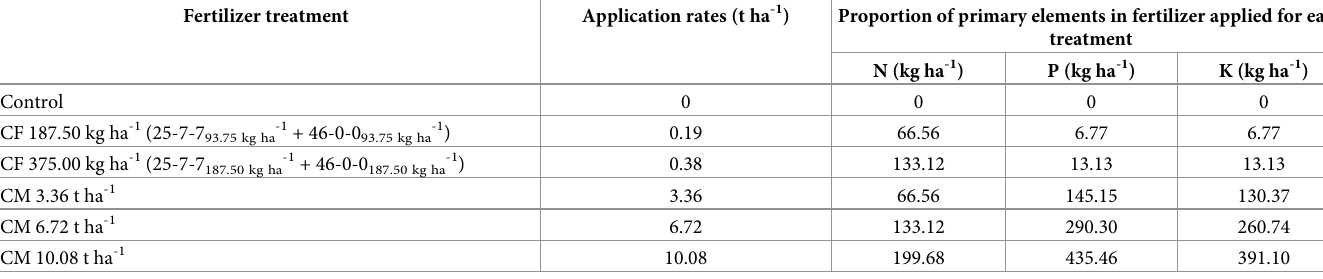
Table 2. Background plant nutrient contents when various fertilizers were applied at each time point. Fertilizer